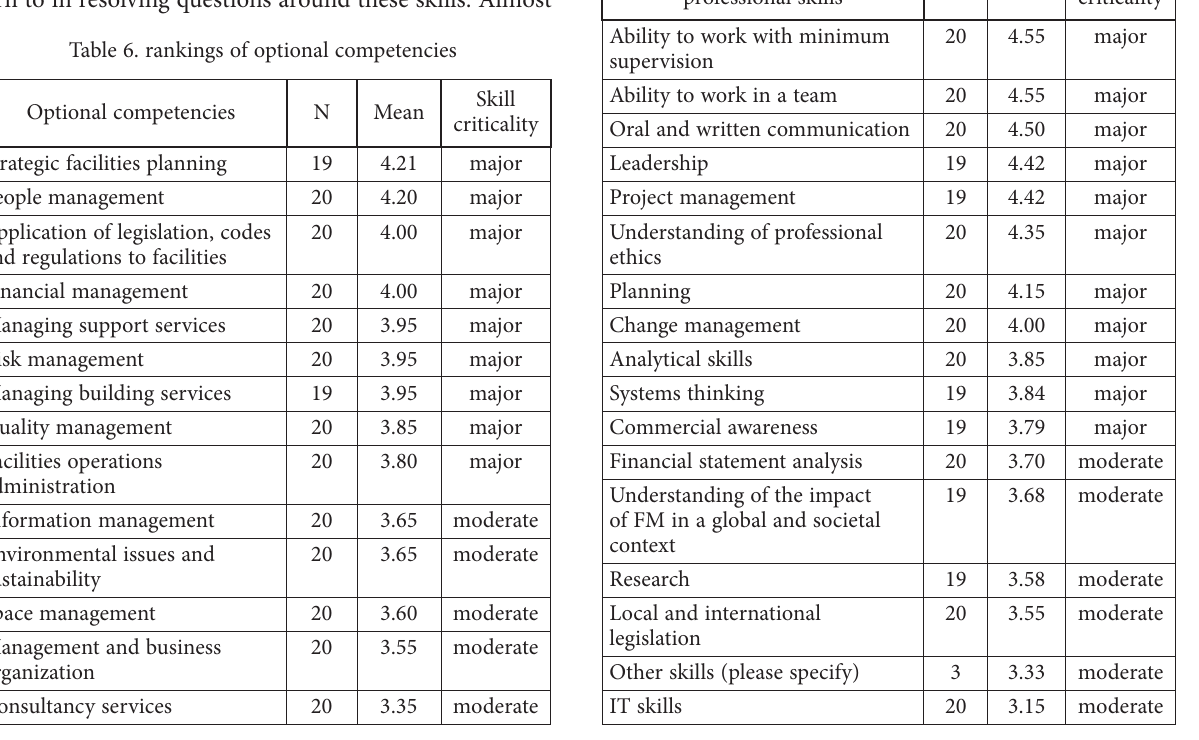
Table 7. Personal, interpersonal and professional skills Personal, interpersonal and professional